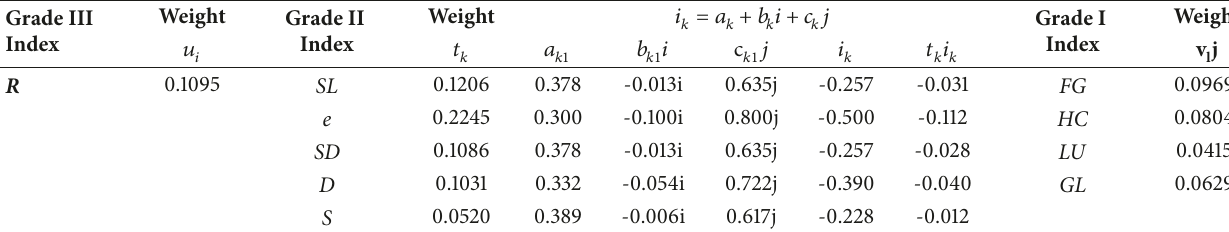
Table 16: Results of connection degree 𝜇(𝐴,𝐵 3 ) A